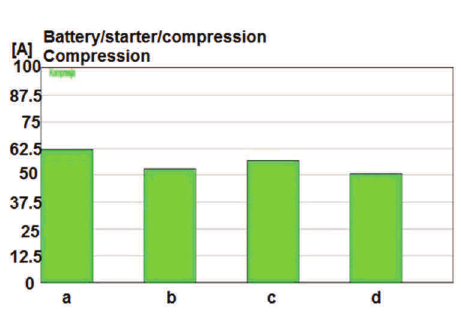
Fig. 8. Starting current for all spark plugs